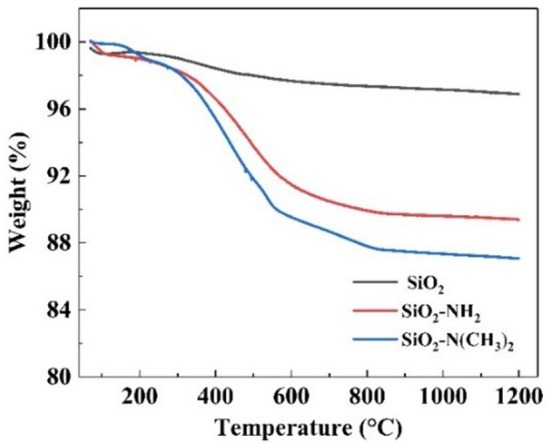
TGA thermograms of raw nano–SiO2, NS–NH2, and NS–NR2.